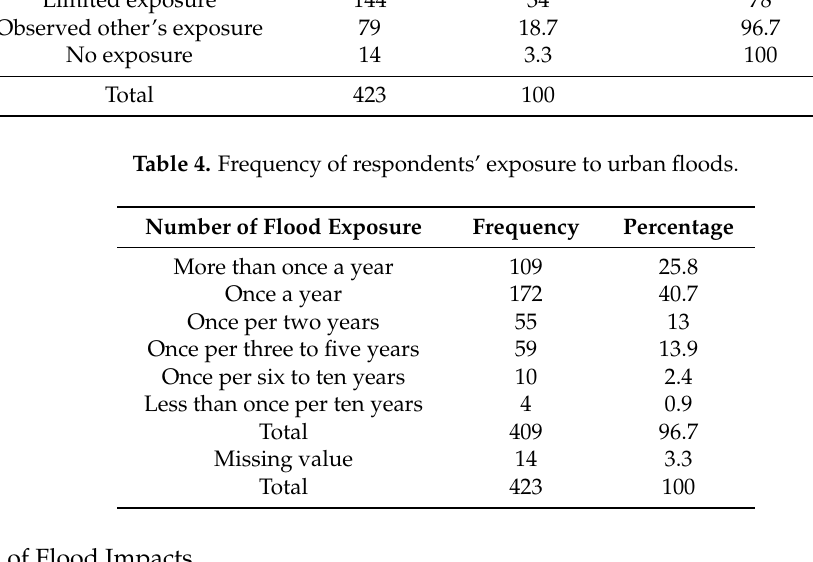
Table 3. Respondents’ exposure to urban floods.